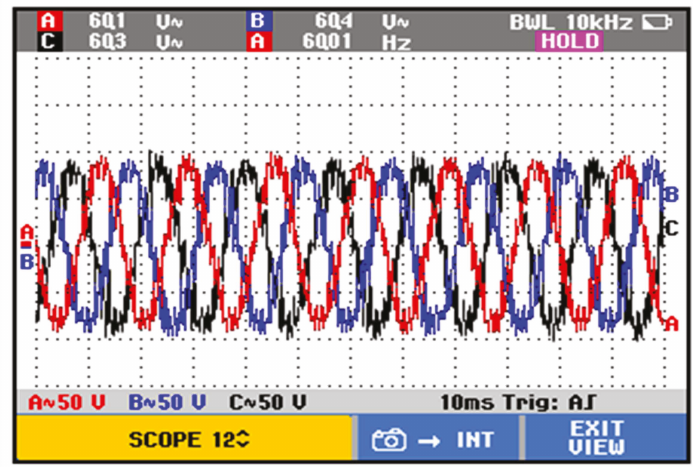
Figure 23: Experimental three-phase line-line voltages generated from con fi guration